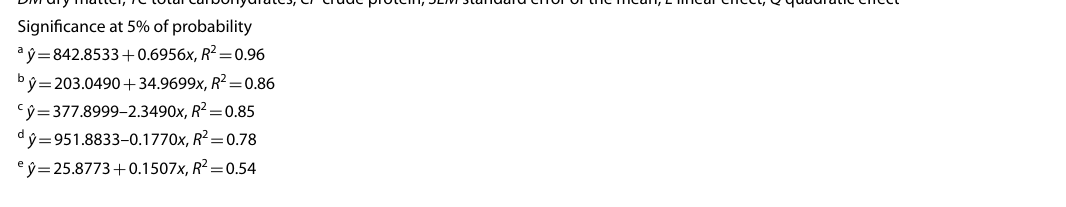
DM dry matter, TC total carbohydrates, CP crude protein, SEM standard error of the mean, L linear effect, Q quadratic effect